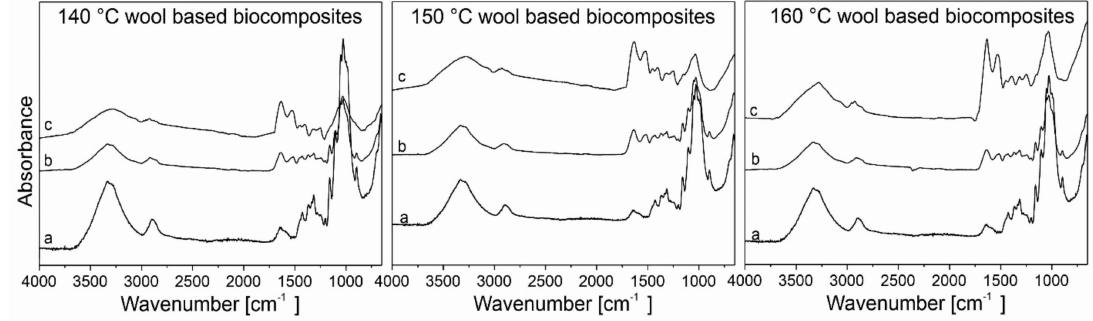
Figure 5. FTIR spectra of kraft pulp biocomposite, superheated water hydrolyzed wool, and kraft cellulose pulp biocompos- ite and biodegradation after 90 days: ( a ) 100% kraft cellulose pulp biocomposite; ( b ) 50%-50% Kraft pulp/hydrolyzed wool biocomposite after 0 days ( c ) and 90 days,